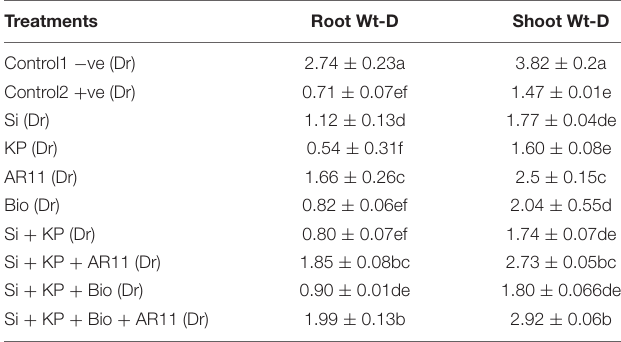
TABLE 4 | Effect of silicon, K 2 HPO 4 , AR11, and biochar on morphological attributes under drought stress. Treatments